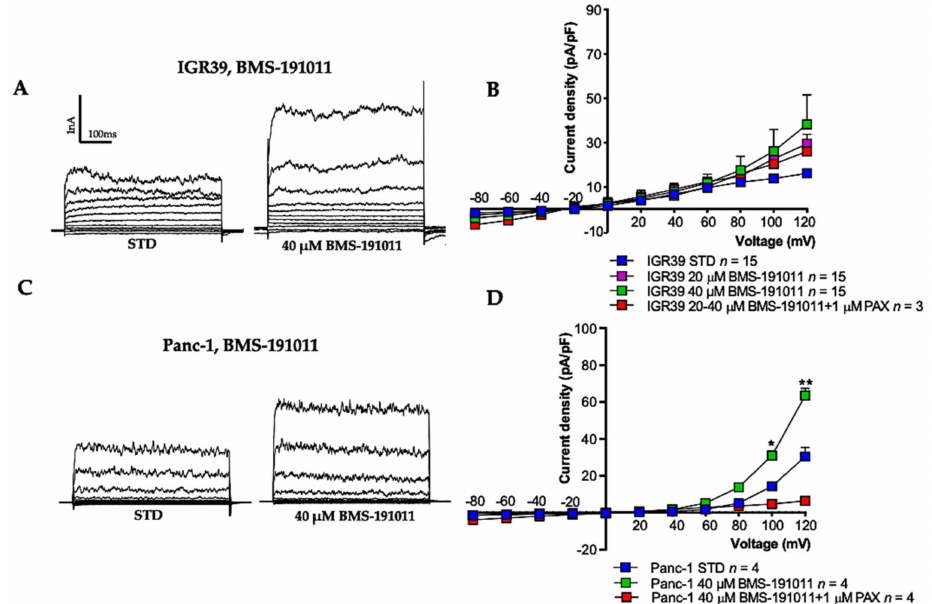
Figure 4. Effect of BMS-191011 on membrane current in IGR39 and Panc-1 cells. Representa- tive current traces obtained before and after BMS-191011 addition in cells stimulated with volt- age increments of +20 mV from − 80 to +120 mV applied from a holding potential of − 50 mV in ( A ) IGR39, or alternatively in ( C ) Panc-1. Current density–voltage relationship measured in whole-cell patch-clamp experiments ( B ) in IGR39 and ( D ) in Panc-1. Exposure to 40 µ M BMS-191011 induced a moderate BK current in IGR39 cells and only a slight activation in Panc-1 cells. * p < 0.05, ** p < 0.01 versus STD condition, as determined by paired Student’s t -test. (n) refers to the number of cells. Note that in this figure, a different range of current density is indicated to that of Figures 2 and